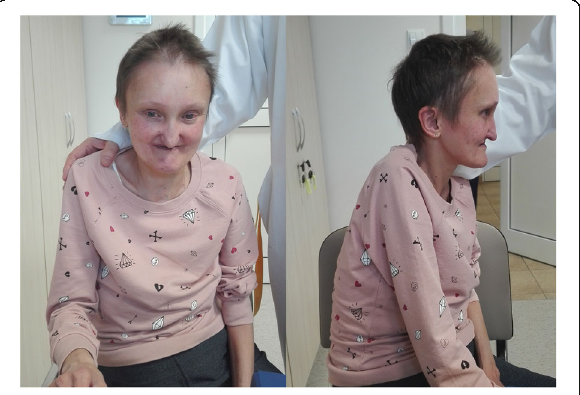
Fig. 1 Dysmorphic facial features of the patient: prominent forehead, deep set eyes, pointed and small chin,